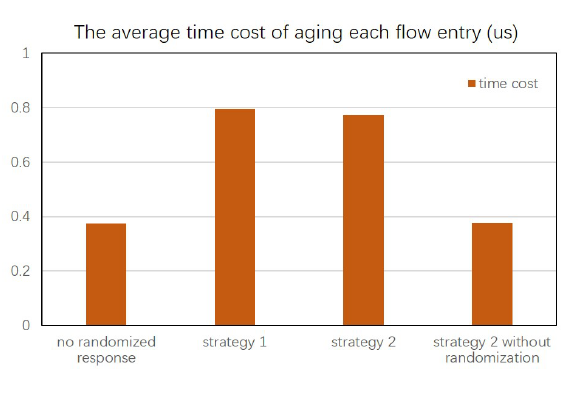
Figure 9. The average time cost of aging a flow entry. The items of no randomized response, strategy 1, strategy 2 and strategy 2 without randomization are the time cost without applying staircase randomized response, applying staircase randomized response strategy 1 and applying staircase randomized response strategy 2 but the probability p is not randomly